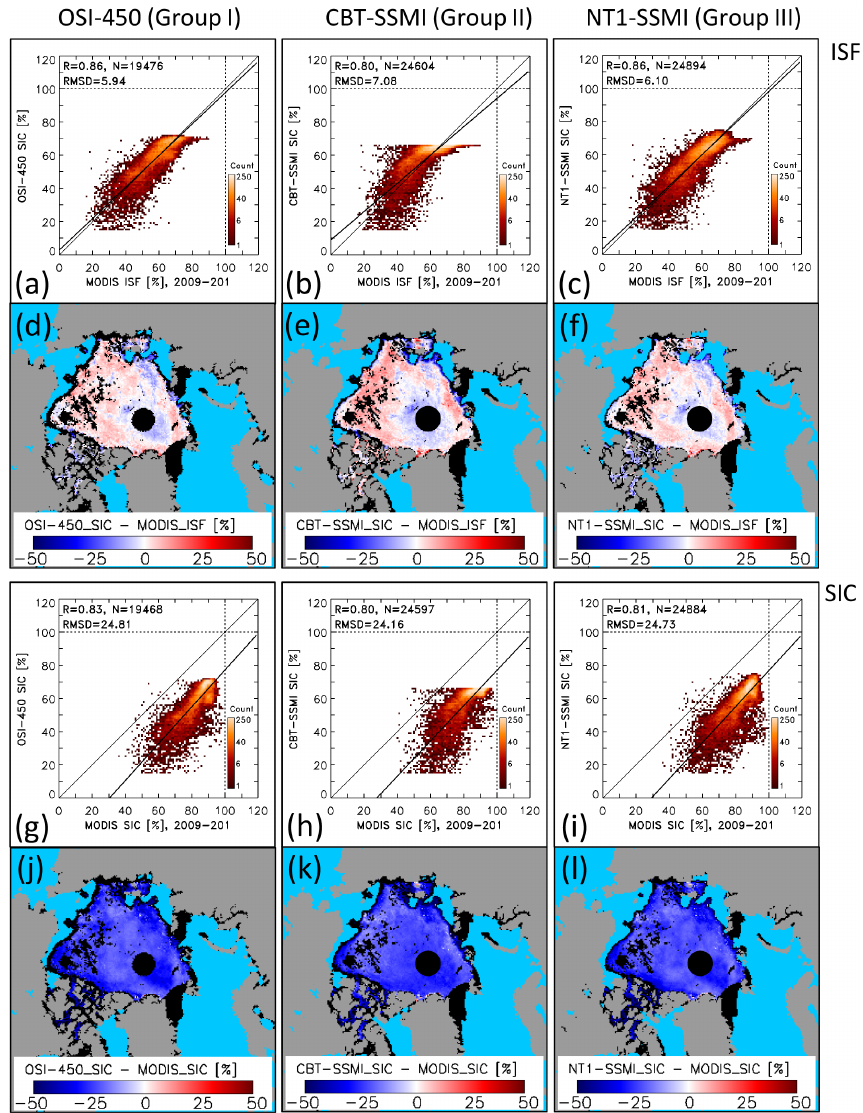
Figure 10. Illustration of the effect of a simple linear bias correction of PMW SIC towards MODIS ISF for an 8d period during peak melt (DOY 201, 20–27 July 2009). (a–c) Two-dimensional histograms of the distribution of bias-corrected PMW SIC ( y axis) versus MODIS ISF ( x axis) data pairs. (d–f) Respective maps of the difference of bias-corrected PMW SIC minus MODIS ISF. (g–i) Two-dimensional histograms of the distribution of bias-corrected PMW SIC ( y axis) versus MODIS SIC ( x axis) data pairs. (j–l) Respective maps of the difference of bias-corrected PMW SIC minus MODIS SIC. The leftmost, middle, and rightmost columns show OSI-450 (for group I), CBT- SSMI (for group II), and NT1-SSMI (for group III). Bin size in the histograms is 1%. The quantities given in the top left corner are R : linear correlation coefficient, N : number of valid data pairs, and RMSD: root-mean-squared difference. The thin black line is the identity line; the thick black line denotes the linear regression through the data